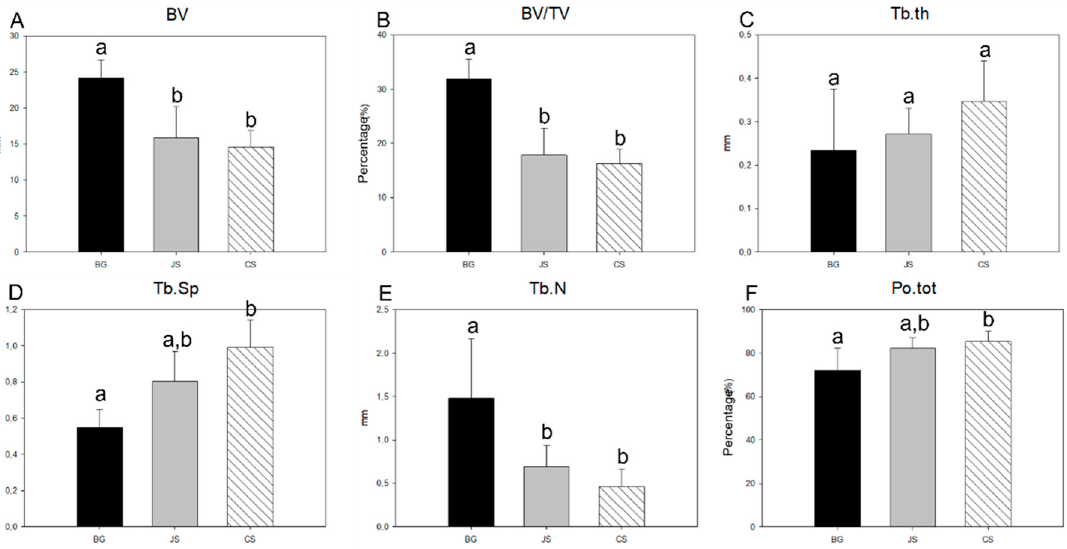
Figure 9. Graphs showing the mean and standard deviation of ( A ) BV, ( B ) BV/TV, ( C ) Tb.th, ( D ) Tb.Sp, ( E ) Tb.N, ( F ) Po.tot at 60 days for the BG, JS, and CS groups. Statistically significant differences between the groups are represented by the different lowercase letters (a, b, and c).